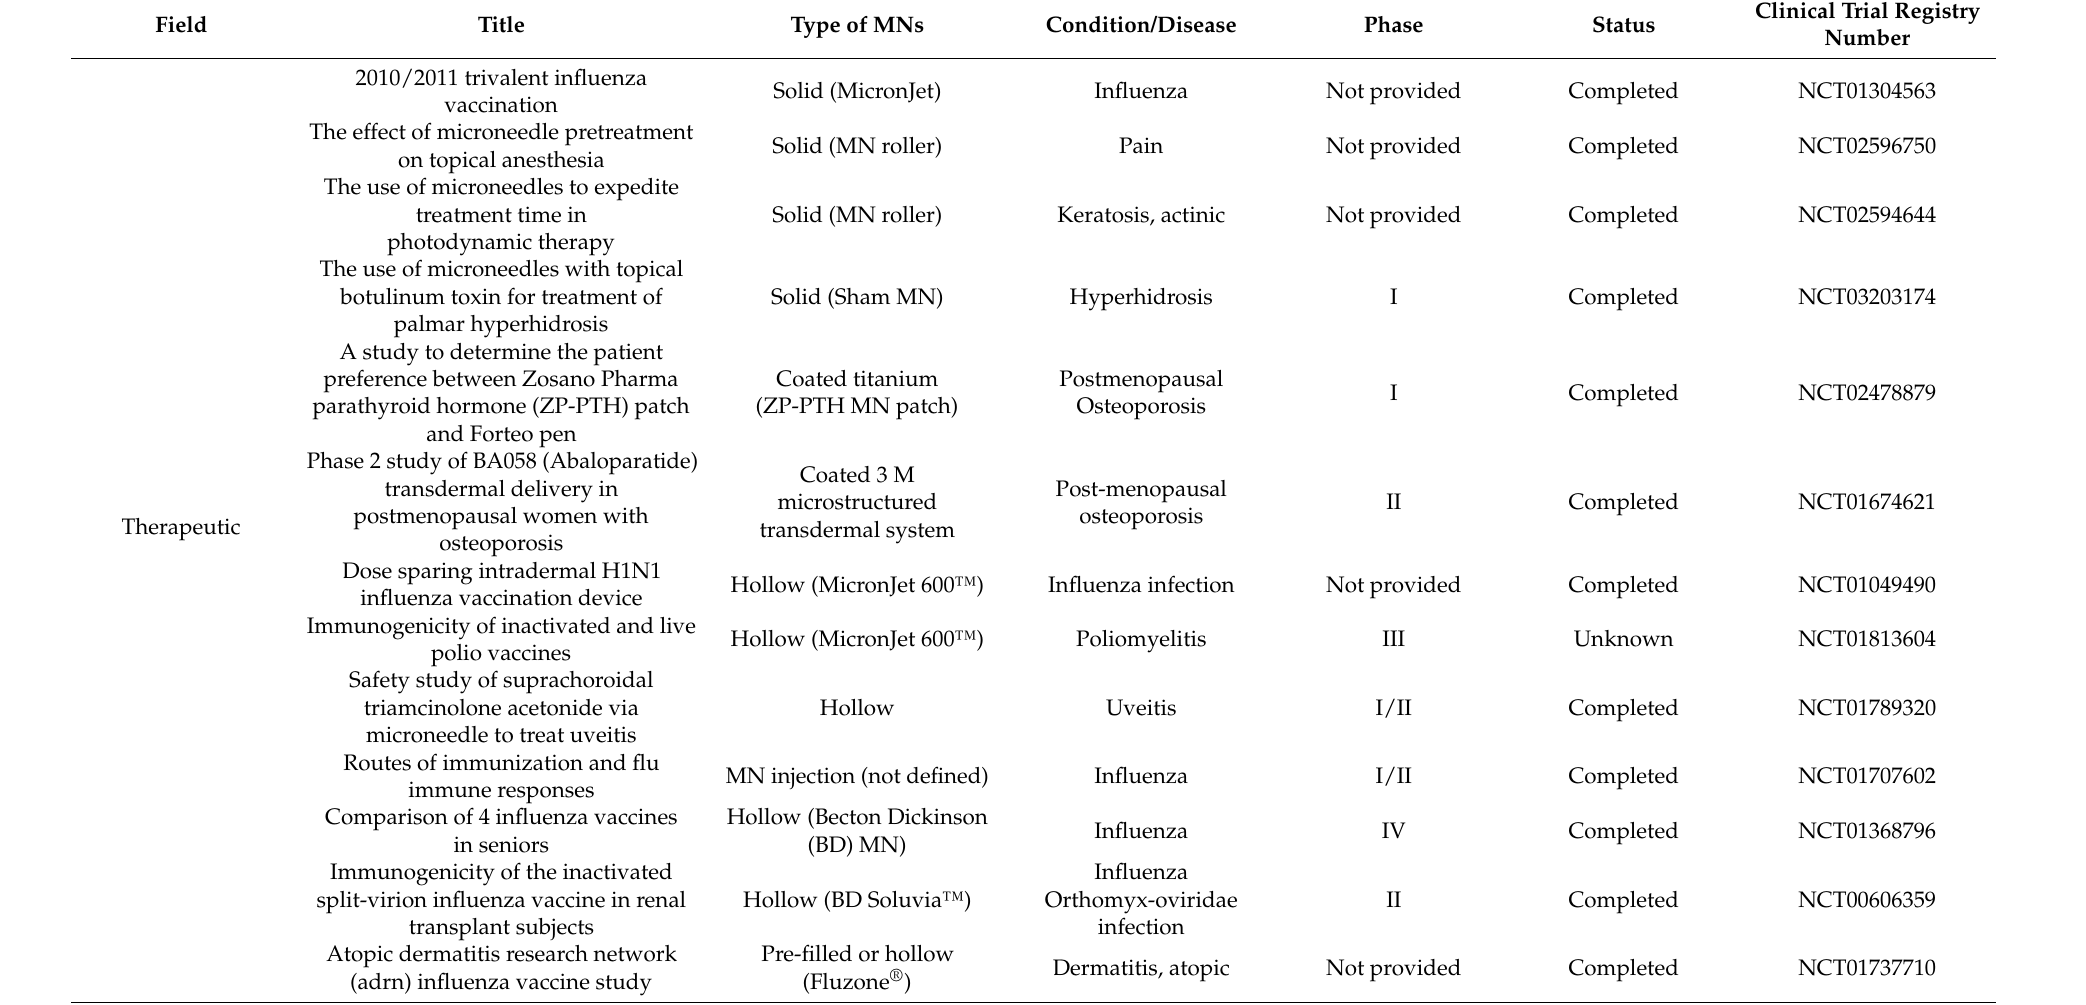
Table 4. Clinical trials and their current status